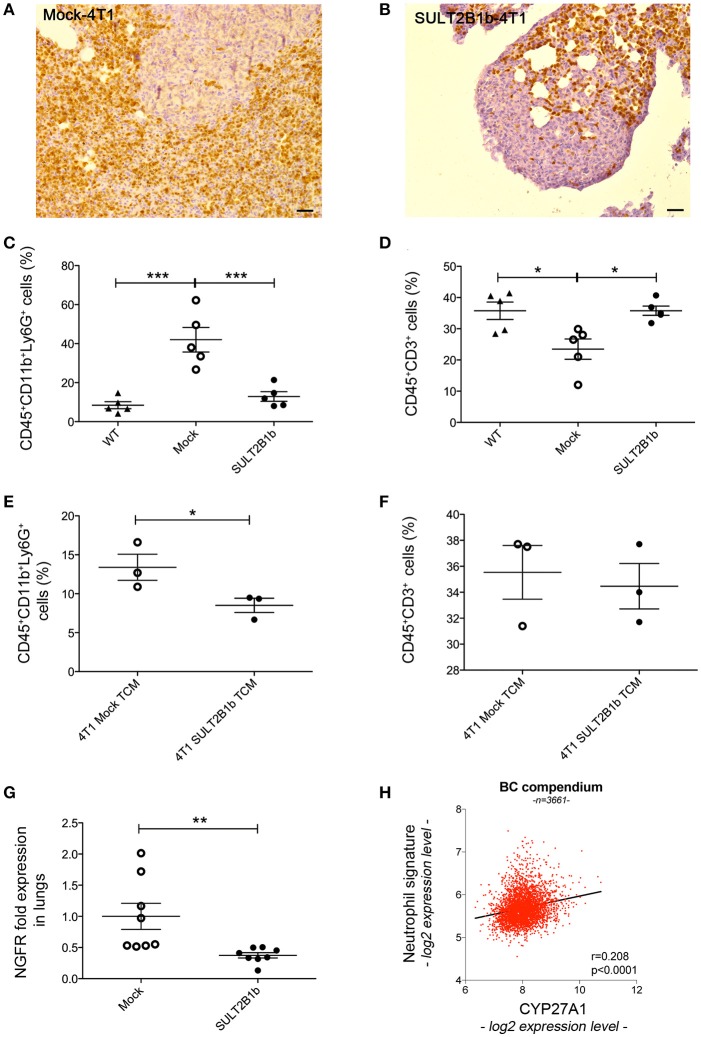
SULT2B1b expression in the primary tumors affects the lung metastatic niche. (A,B) Immunoistochemical analysis of Mock-4T1 (A) and SULT2B1b-4T1 (B) lung metastases immunostained with anti-Ly6G mAb. The density of Ly6G+ neutrophils is reduced in SULT2B1b-4T1 tumors (B). Original magnification 200x; bar, 100 μm. (C,D) Percentage of neutrophils (C) and CD3+ T-cells (D) by flow cytometry analysis of naïve lungs, Mock-4T1 and SULT2B1b-4T1 lung metastases after mechanical and enzymatic digestion. *p < 0.05; ***p < 0.001 (ANOVA). (E,F) Percentage of neutrophils (E) and CD3+ T-cells (F) by flow cytometry analysis of lungs collected from naïve mice treated with tumor conditioned media (TCM) from Mock-4T1 and SULT2B1b-4T1 tumors, after mechanical and enzymatic digestion. *p < 0.05; (Student's t-test). (G) qPCR analysis for NGFR expression of lungs from Mock-4T1 and SULT2B1b-4T1 tumor-bearing NOD-SCID mice. **p < 0.01. (Student's t test). (H) Scatter plot (red dots) and linear regression (black line, slope 0.532) of expression values indicate a positive correlation between the expression level of CYP27A1 and a neutrophil gene signature, in a compendium of 3661 primary human breast cancers (see Materials and Methods). The Pearson ρ quantifies the linear dependence between the expression levels of CYP27A1 and of the neutrophil signature (p-value < 0.0001).